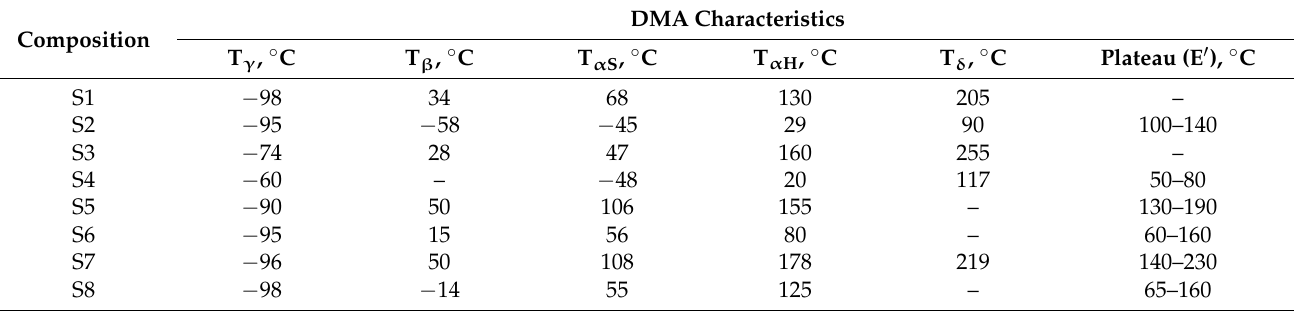
Table 3. Thermomechanical properties of segmented